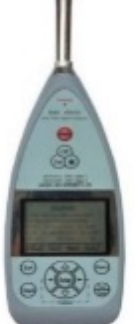
Figure 7. Sound level meter.